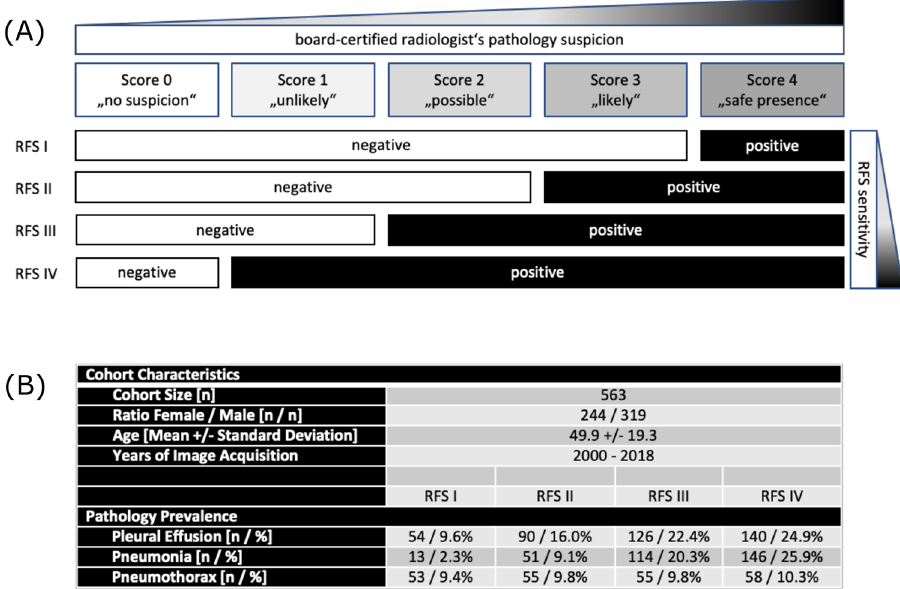
Figure 1. Reference standard and characteristics in the CXR EU cohort; ( A ) illustrates the definition of reference standards based on suspicion scores of the board-certified radiologists. According to the principle of a majority voting 4 reference standards (RFS) were built—RFS I being the most specific and RFS IV being the most sensitive one; ( B ) illustrates cohorts characteristics and pathology prevalence according to RFS I–IV.